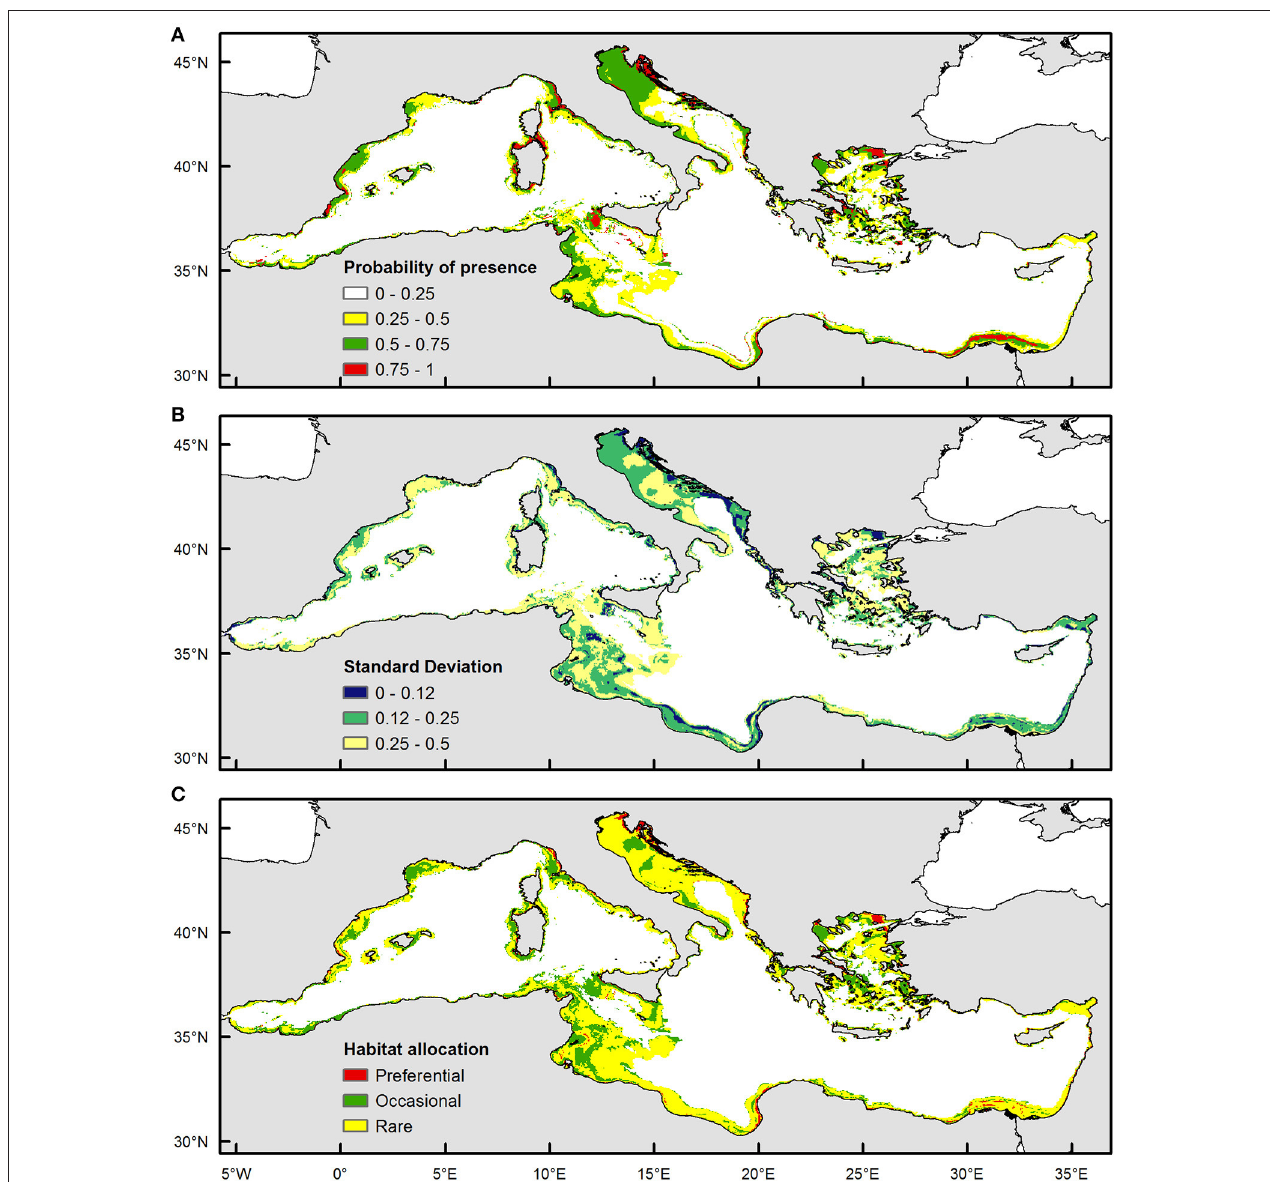
FIGURE 3 | Habitat suitability maps based on pooled model for juvenile Atlantic mackerel in the Mediterranean Sea for June 2003–2010. (A) Mean probability map (B) Standard Deviation Map (C) Habitat allocation map.